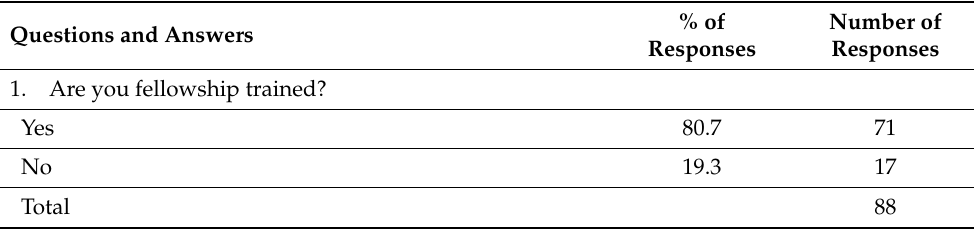
Table 1. Upper Urinary Tract Urothelial Carcinoma Management questionnaire and responses (No multiple answers were possible unless stated